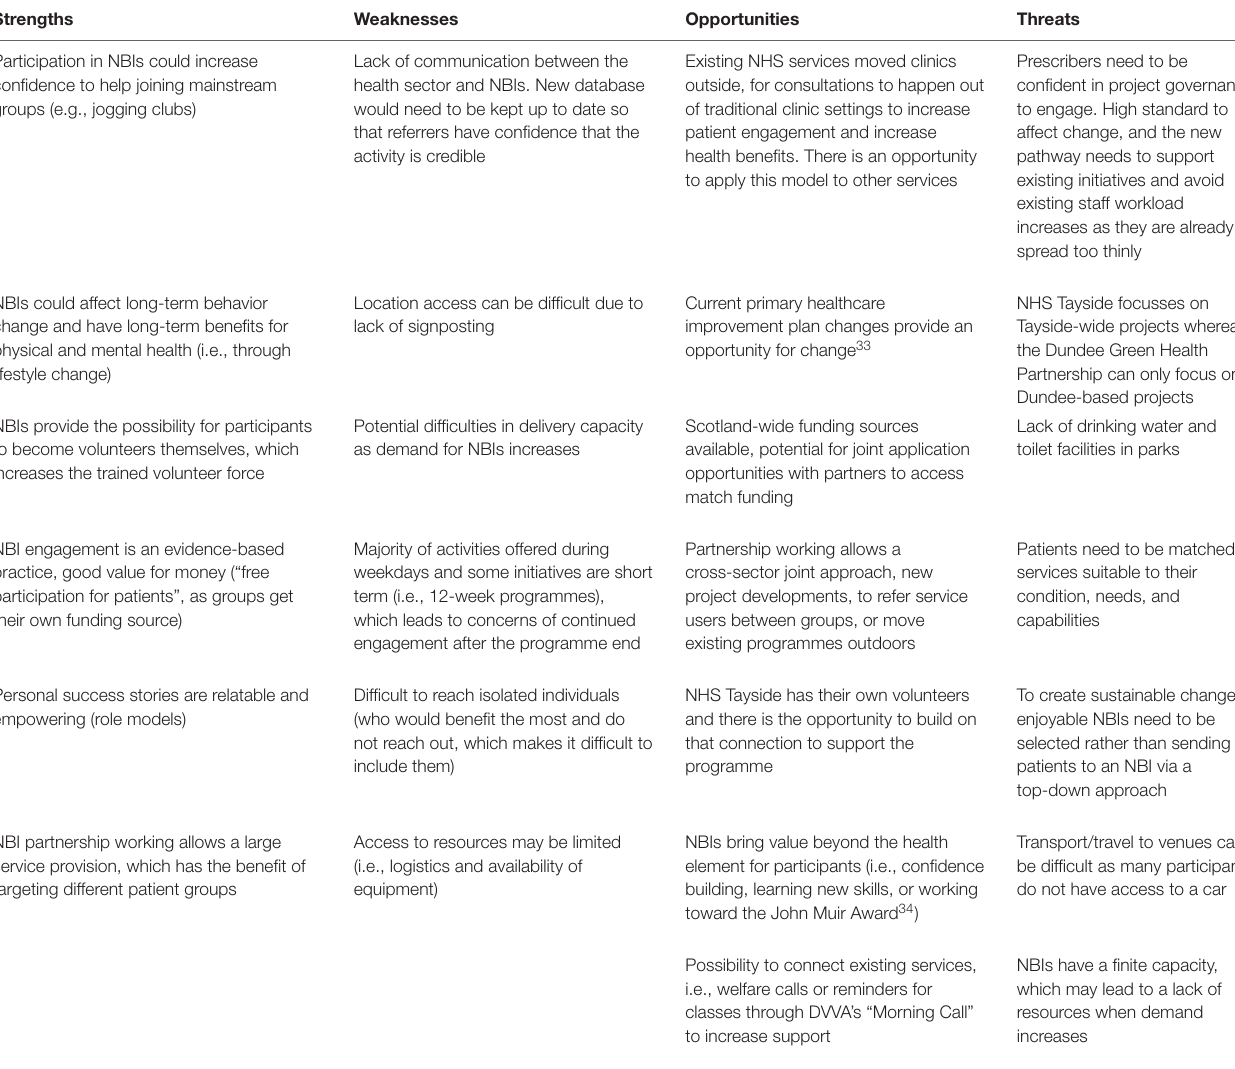
TABLE 3 | NBI Stakeholder SWOT